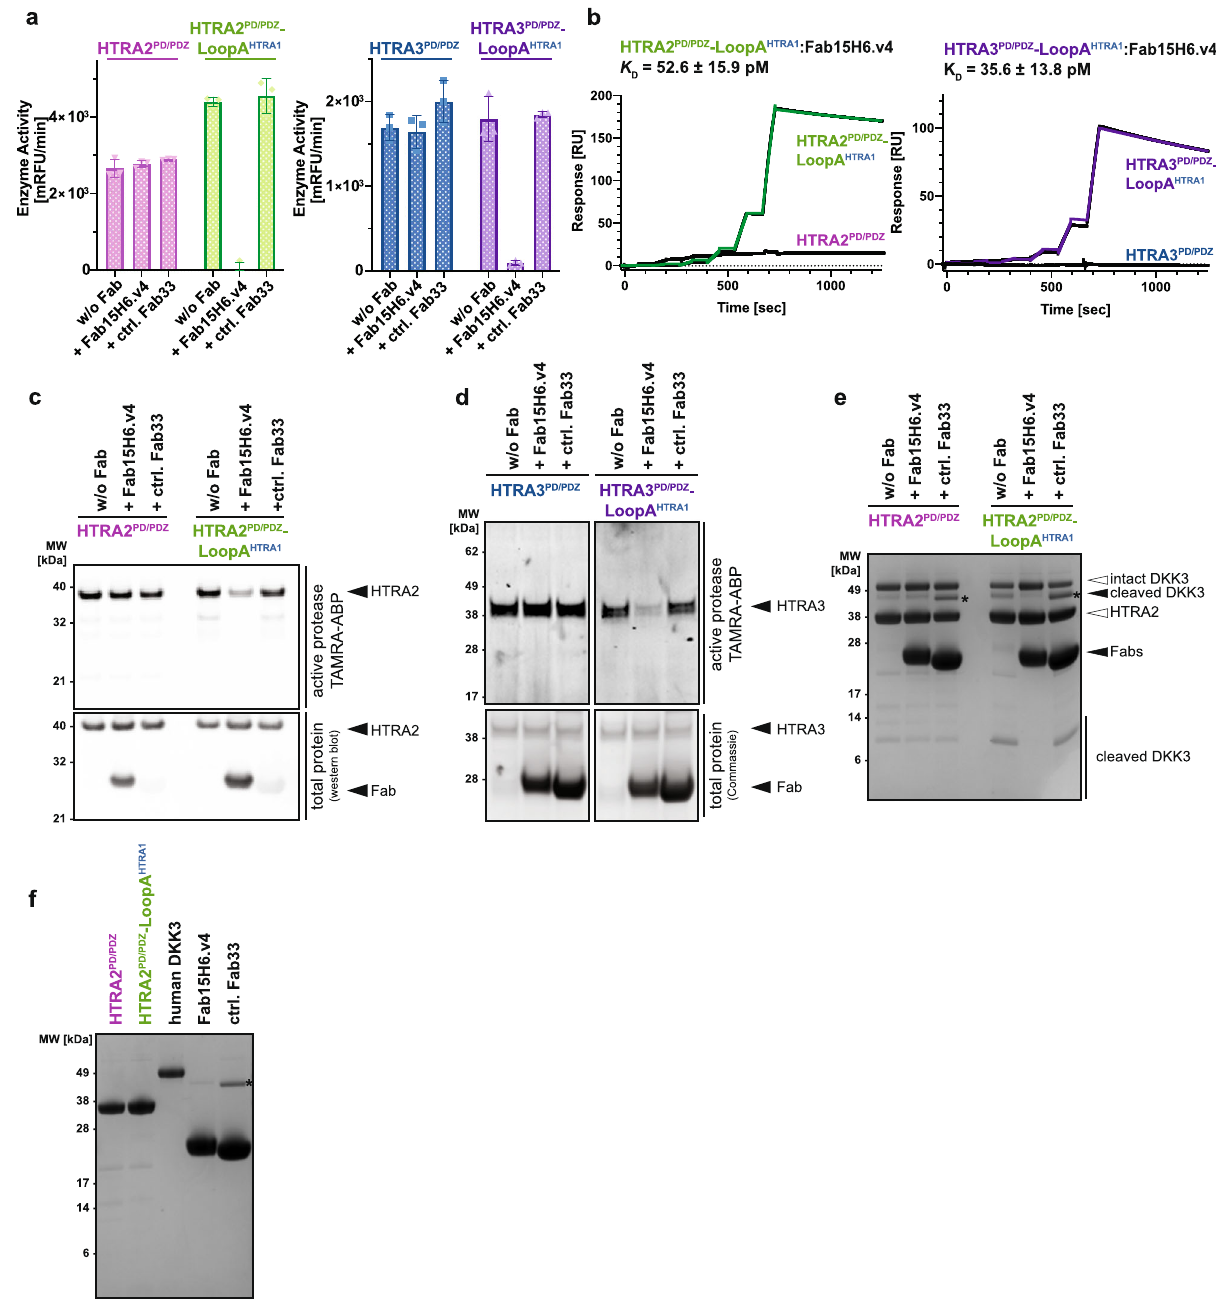
Fig. 6 | Transfer of the Fab15H6.v4 allosteric inhibition mechanism to HTRA2 and HTRA3. a Enzymatic activity of wildtype HTRA2 PD/PDZ (pink) and HTRA3 PD/PDZ (blue)comparedtothechimericHTRA2 PD/PDZ -LoopA HTRA1 (green)andHTRA3 PD/PDZ - LoopA HTRA1 (purple) proteins in the presence of Fab15H6.v4 or control Fab33. b SPR binding kinetics of Fab15H6.v4 interaction with wildtype HTRA2 PD/PDZ and HTRA3 PD/PDZ and their LoopA chimeras. c , d Labeling of HTRA2 PD/PDZ and HTRA3 PD/ PDZ wildtypeproteinscomparedtotheLoopAchimerasusing fl uorescentactivity- based probe (TAMRA-ABP) in the absence or presence of Fab15H6.v4 or control Fab33. e In-vitro cleavage of DKK3 substrate using wildtype HTRA2 PD/PDZ or